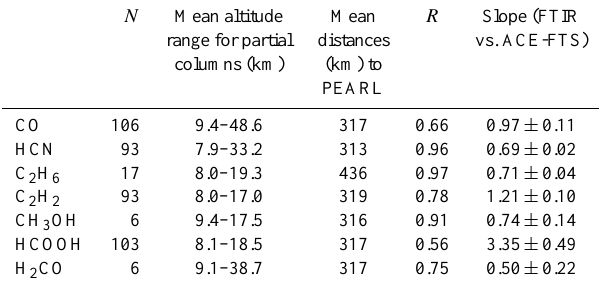
Table 5. Comparison of FTIR and ACE-FTS partial columns for all trace gases derived in this study. N is the number of coinci- dences involved in the comparison. The second column gives the mean altitude ranges used for the partial-column calculations, and the third column shows the mean distance of ACE-FTS occulta- tions to PEARL. R is the correlation coefficient, and the fifth col- umn gives the values of the slope of the regression plot between the FTIR partial columns and the coincident ACE-FTS measurements along with the 1 σ uncertainties of the slopes for each target